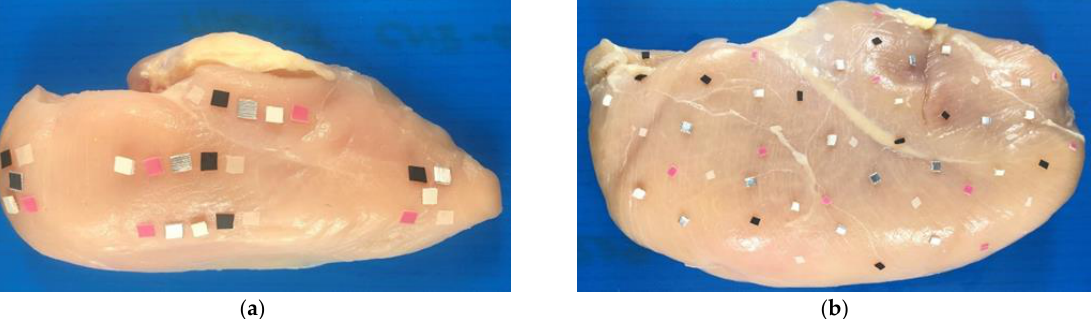
Figure 2. Chicken breast fillets contaminated ( a ) with 5 × 5 mm 2 pieces of FMs and ( b ) with 2 × 2 mm 2 pieces of